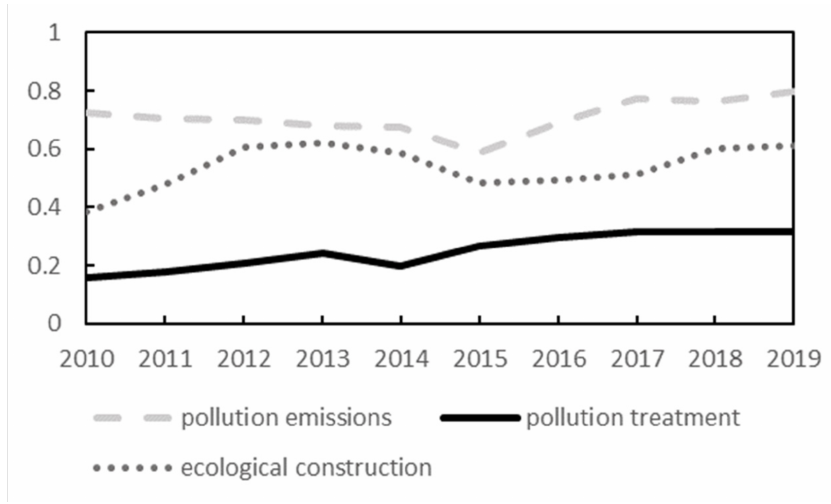
Figure 4. Changes in the ecological integrated indexes in the Yellow River basin (data obtained by averaging three standardized results).